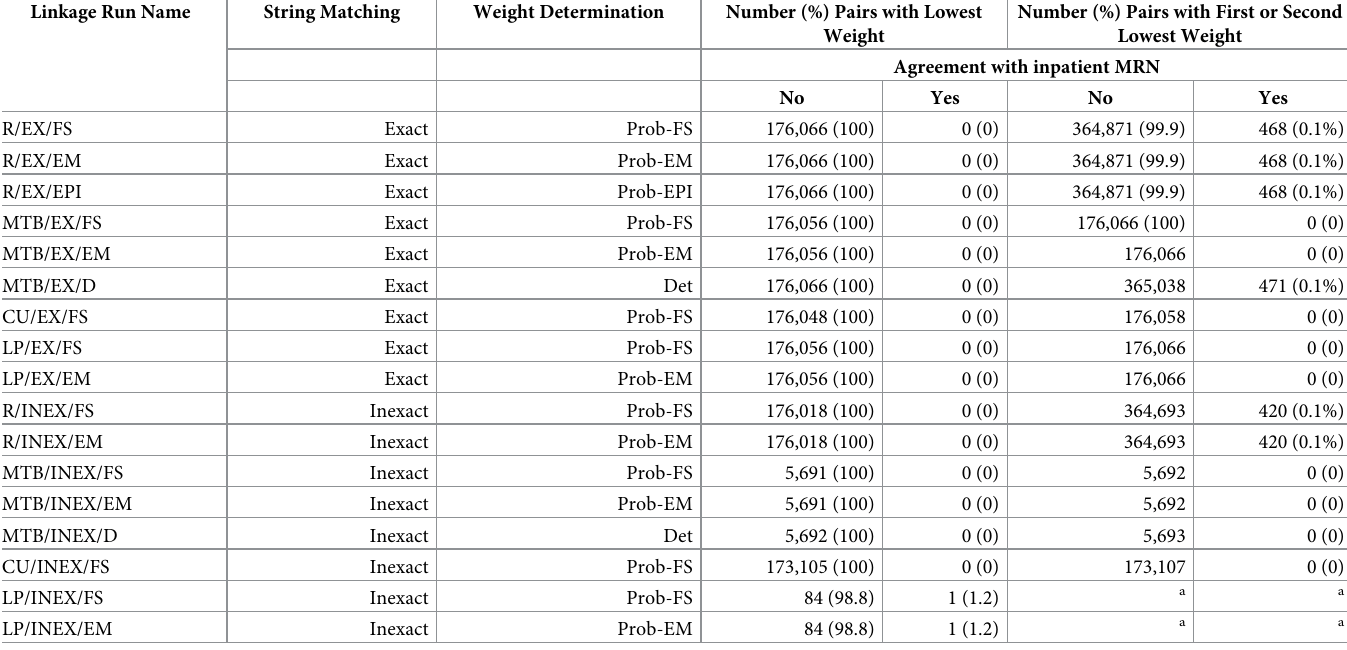
Table 5. Agreement with gold standard among records with the lowest weights, blocking on DOB.